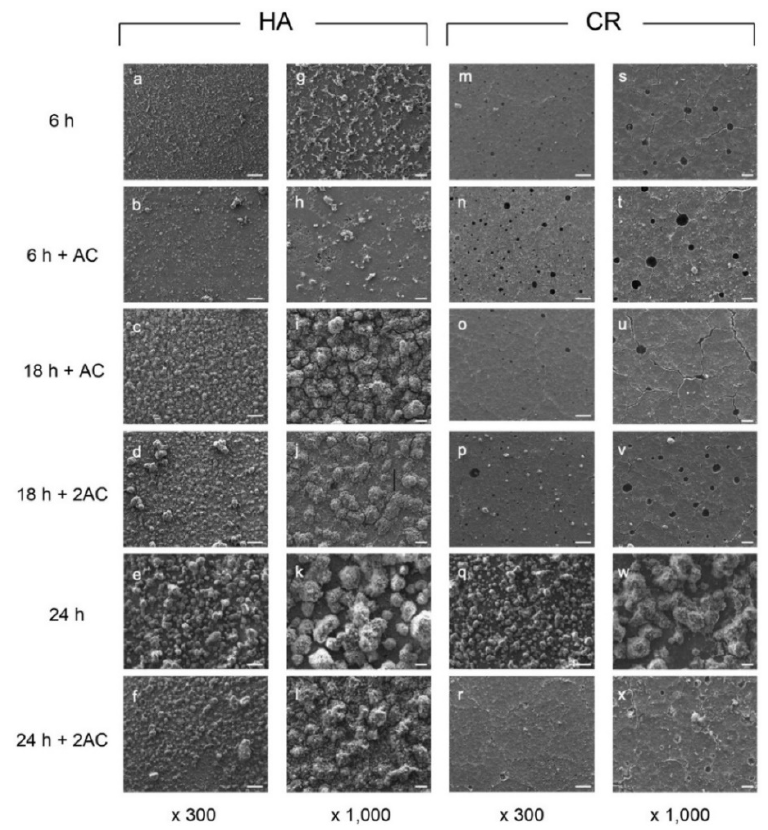
Figure 2. Representative SEM images of S. mutans biofilm formed on the HA ( a – l ) and the CR ( m – x ) at defined incubation times. 6 h: 6 h of culture; 6 h + AC: A single exposure of 1M acetic acid (pH 4.5) for 30 min after 6 h of incubation; 18 h + AC: The specimen was exposed to acidic solution after 6 h of incubation and then cultured up to 18 h; 18 h + 2AC: A second exposure of acetic acid after 18 h of incubation; 24 h: 24 h of culture without acidic treatment; 24 h + 2AC: The specimen was exposed